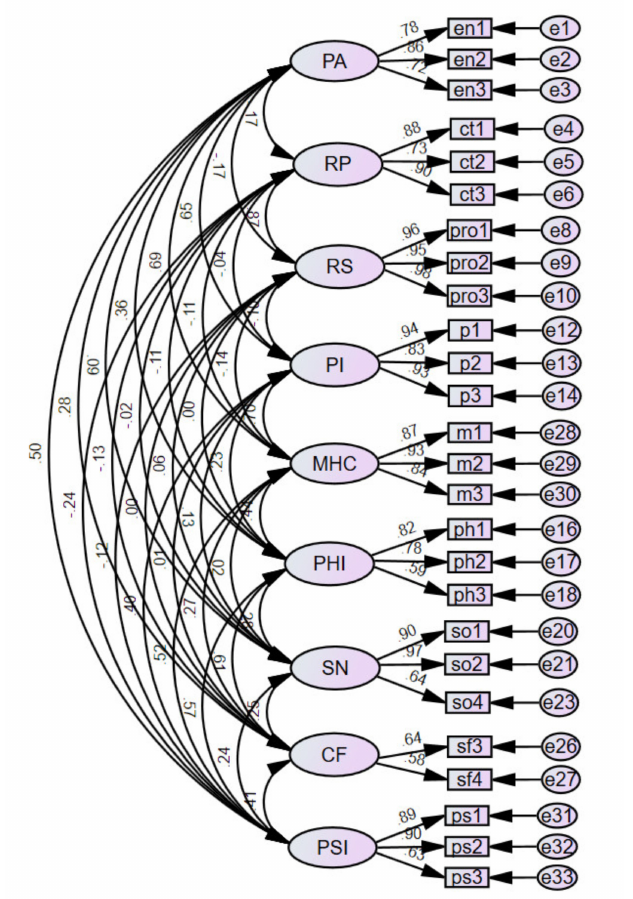
Figure 1. Standardized regression weights of the full measurement model. PA: program atmosphere; RP: relationships with patients; RS: relationships with staff; PI: program involvement; MHC: integra- tion into the mental health community; PHI: physical integration; SN: social network size; CF: social contact frequency; PSI: psychological integration. Table 3. Goodness of fit of the measurement